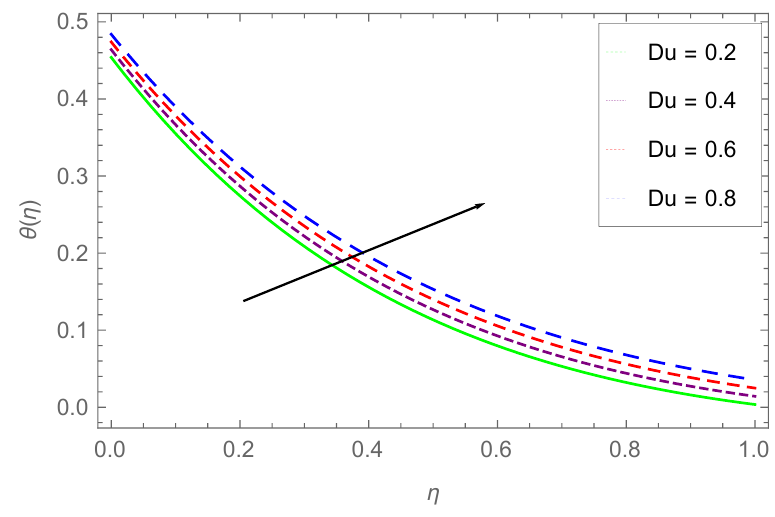
Figure 7. Dependence of θ ( η ) on Du .